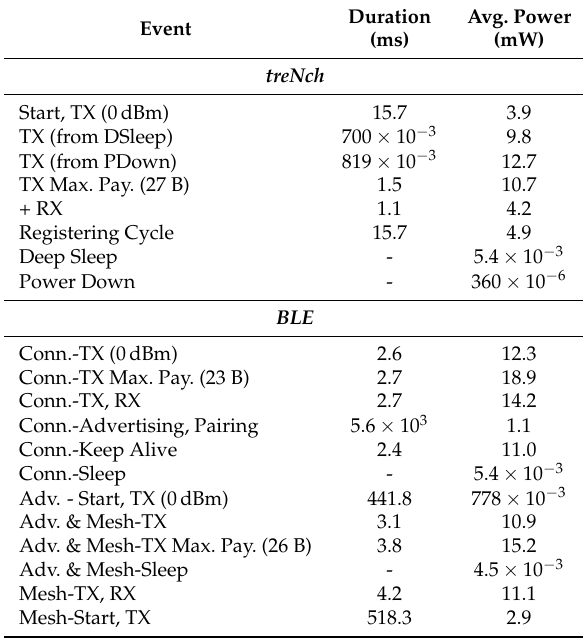
Table 4. Measurements of power consumption for every